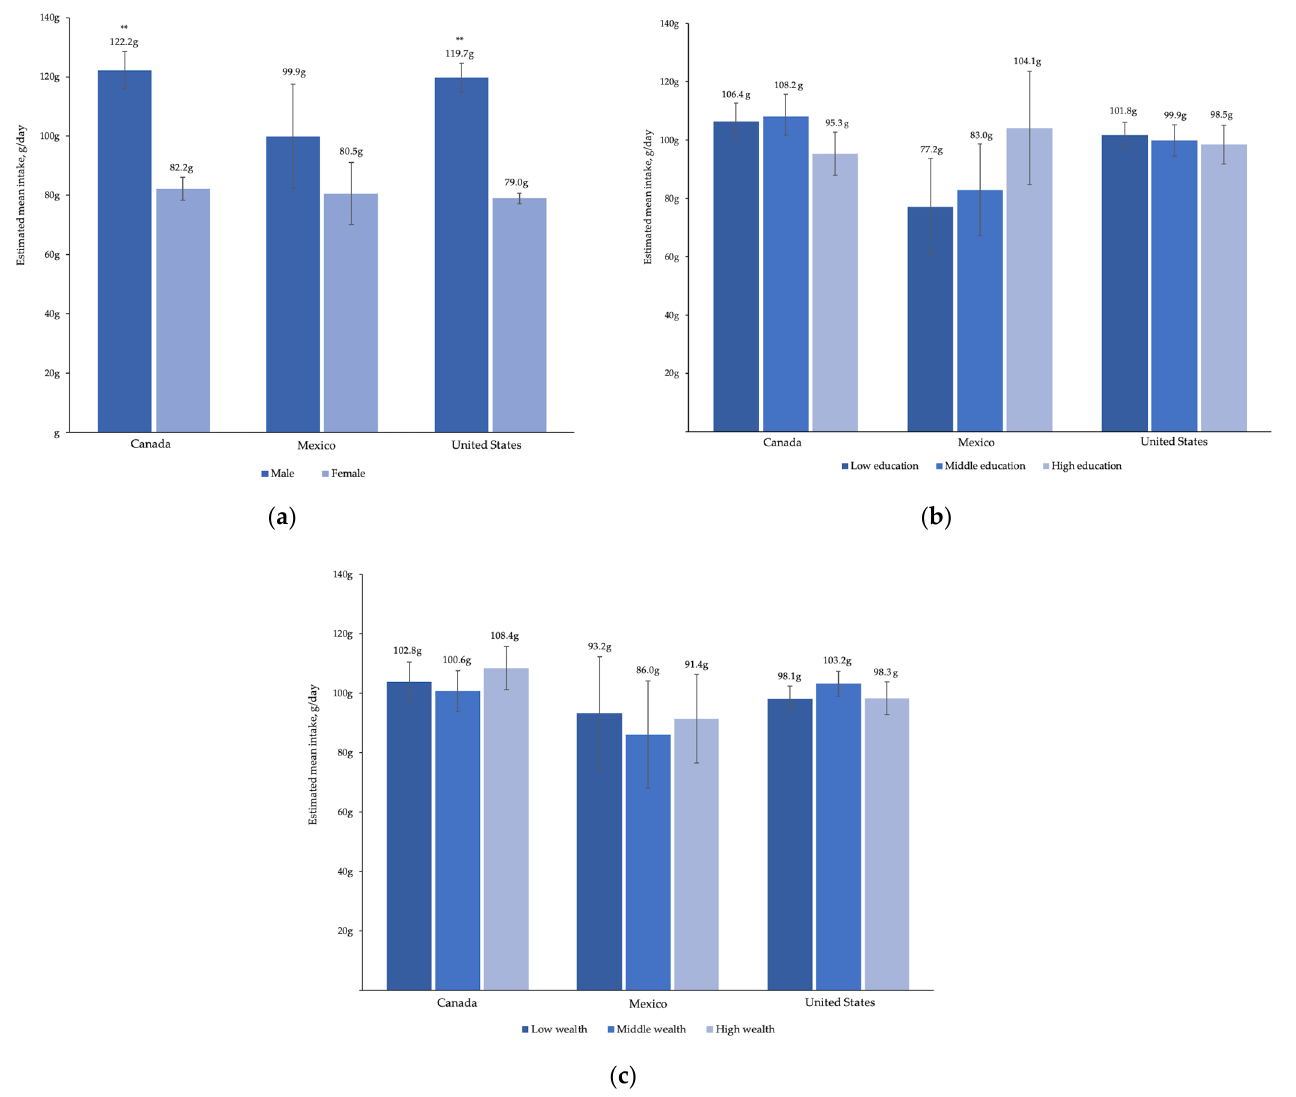
Figure 2. Adjusted estimated mean grams of total meat intake by ( a ) sex, ( b ) education, and ( c ) wealth and income category for one day of 24-h dietary recall data in Canadian Community Health Survey (2015), Mexico National Health and Nutrition Survey (2016), and US National Health and Nutrition Examination Survey (2013–2016). Multivariate generalized linear regression models were adjusted for sex, 10-year age category, educational attainment, and wealth and income category; ** p < 0.001 for the observed difference in estimated mean intake of total meat.